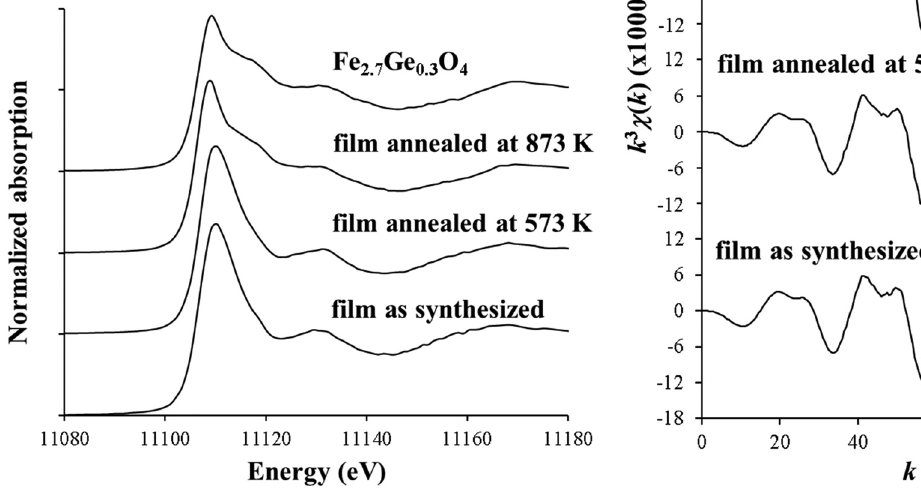
Figure 3: k 3 - weighted EXAFS spectra measured at Ge K absorption edge for as - synthesized and annealed Fe 2.64 Ge 0.36 O 4 films with reference Fe 2.7 Ge 0.3 O 4